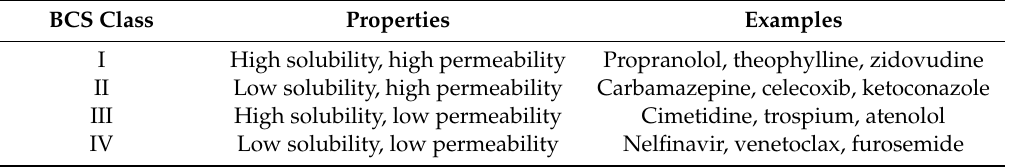
Table 1. Properties and examples of drugs in the four biopharmaceutics classification system